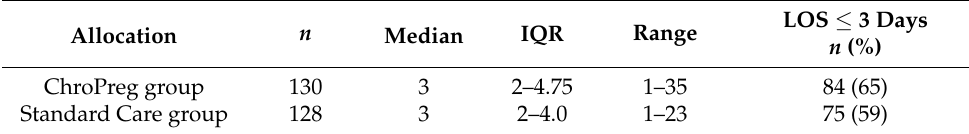
Table 3. Length of hospital stay (LOS) in days according to group